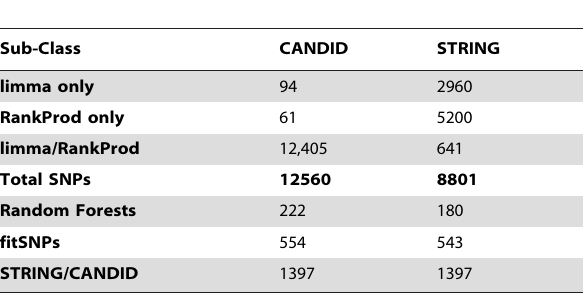
Table 1. Prioritized Probe distribution by category.